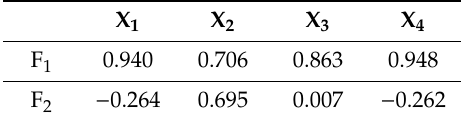
Table 7. Coe ffi cient matrix of the extracted principal components.